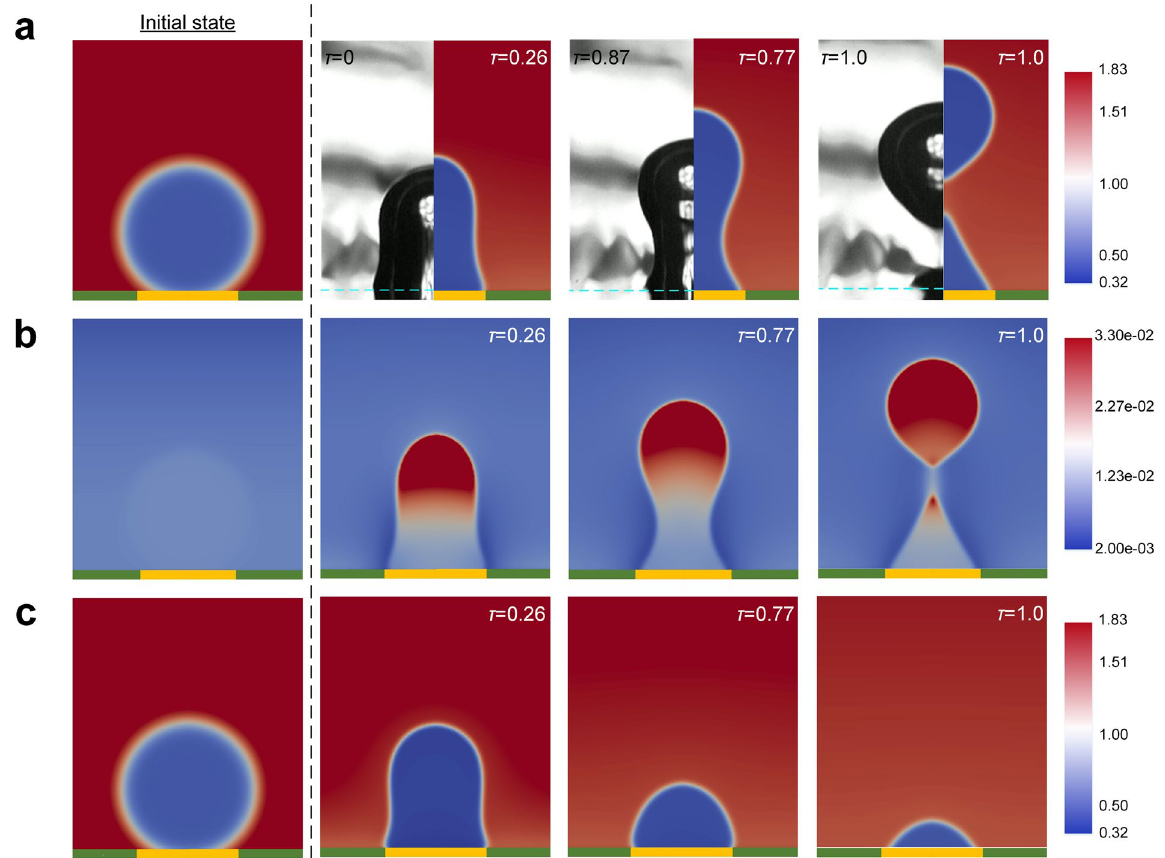
Figure 6. Simulated bubble behaviours with and without the gas presence. ( a ) Bubble pinch-off in a dilute water-nitrogen mixture. The diffuse-interface simulation shows that the vertical bubble deformation leads to the formation of a thinning neck and eventual (partial) departure from the surface. The results compare qualitatively well with the experimental observation at T w = 98.9 °C in the open case (with the heater surface marked by the green dash lines). The colour scale indicates the total fluid density that is normalized by the critical density of water. Here the nondimensional time, τ , is scaled by the bubble departure time (counted from the start of the simulation until the actual instant of bubble pinch-off in the two-component case). For the experiment, on account of the fact that the bubbles largely remain on the surface, the instant τ = 0 is set at the moment of “necking” before final departure. Yellow strip: hydrophobic subregion ( θ e = 120°); green strip: hydrophilic subregion ( θ e = 10°). ( b ) Accumulation of incondensable gas within the bubble. The images show the spatial distributions of nitrogen at the same instants as in (a), whose normalized density is represented by the colour scale. Exceptionally high solute concentrations materialize in the upper part of the bubble as the bubble continues to grow on the hydrophobic surface. Consequently, the bubble pinch-off transpires with the ascent of the top of the bubble filled with incondensable nitrogen. Note that the images of the full bubble are produced by merging the axisymmetric simulation results with their mirror counterparts. In Supplementary Videos M3, we include movies depicting the evolutions of the total density and nitrogen density distributions during bubble departure, respectively. ( c ) Shrinkage of a pure vapour bubble. The results show that a continuously shrinking bubble, under the enhanced (contaminant-free) condensation, fails to depart from the surface. In Supplementary Videos M4, we show the bubble growth and eventual collapse in a single-component